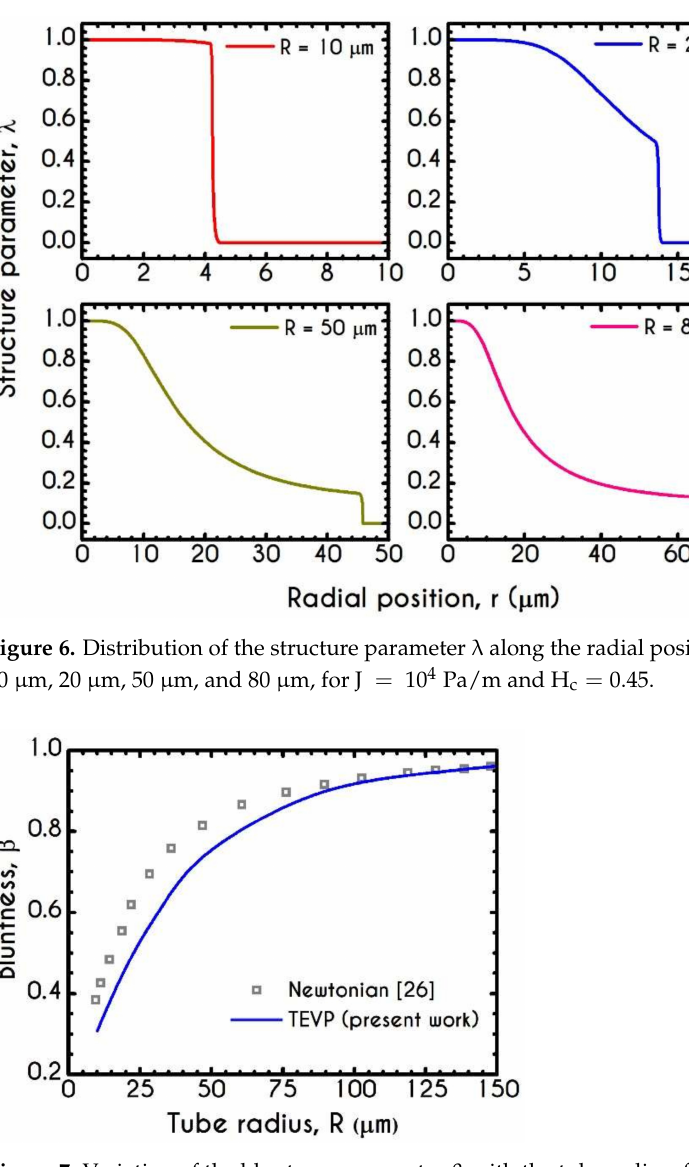
Figure 7. Variation of the bluntness parameter β with the tube radius, for J = 10 4